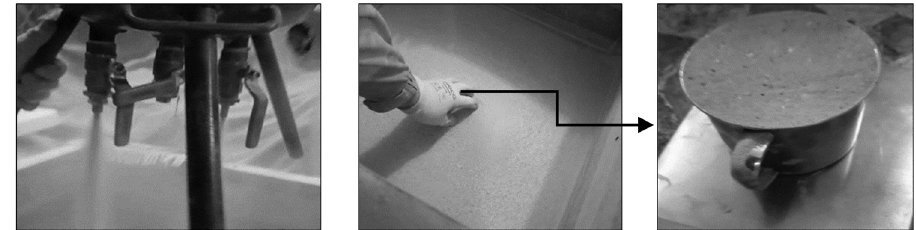
Figure 4: Details of raining test with TARD.